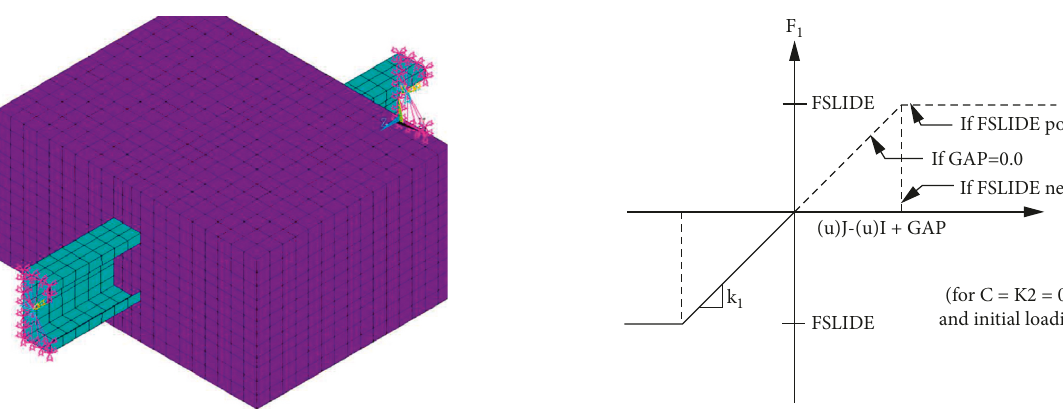
Figure 11: Behavior of COMBIN40 element